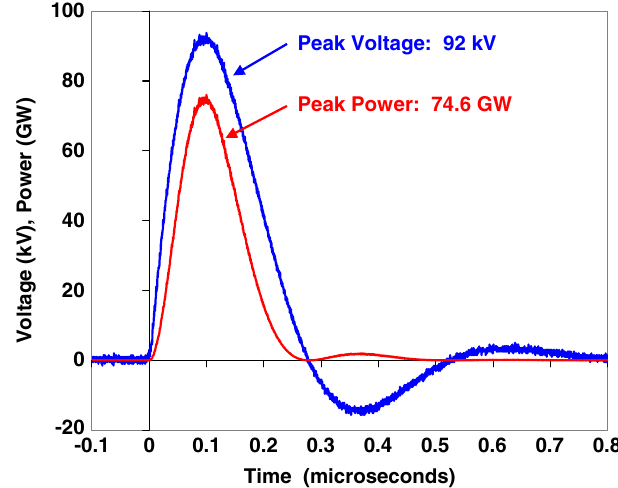
FIG. 9. Load voltage and power waveforms for LTD-III with 58 nF capacitors and Metglas (cid:1) toroids.